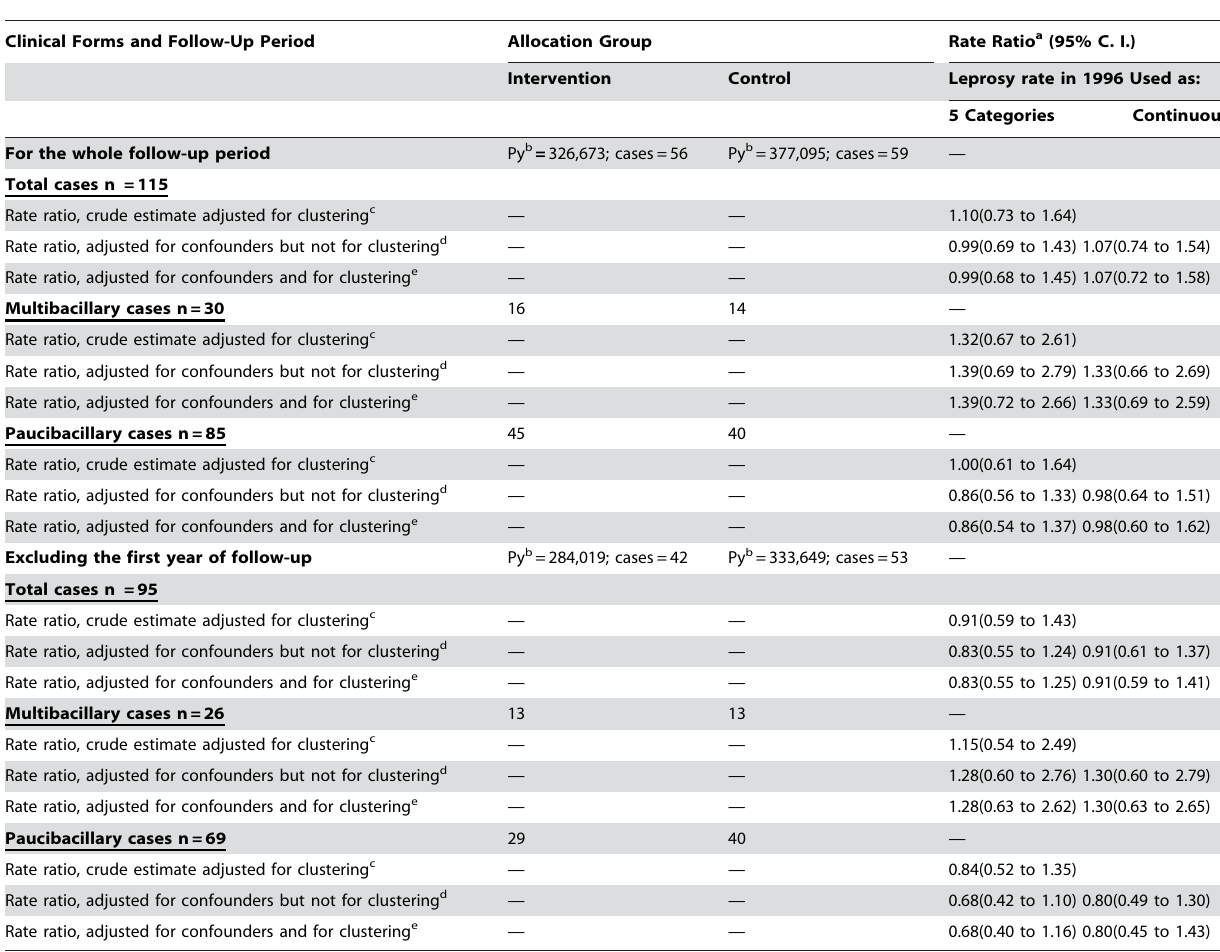
Table 3. Rate ratios between rate in intervention arm over rate in control arm, among those with 1 BCG scar, whether controlled for study variables, separately for clinical forms.